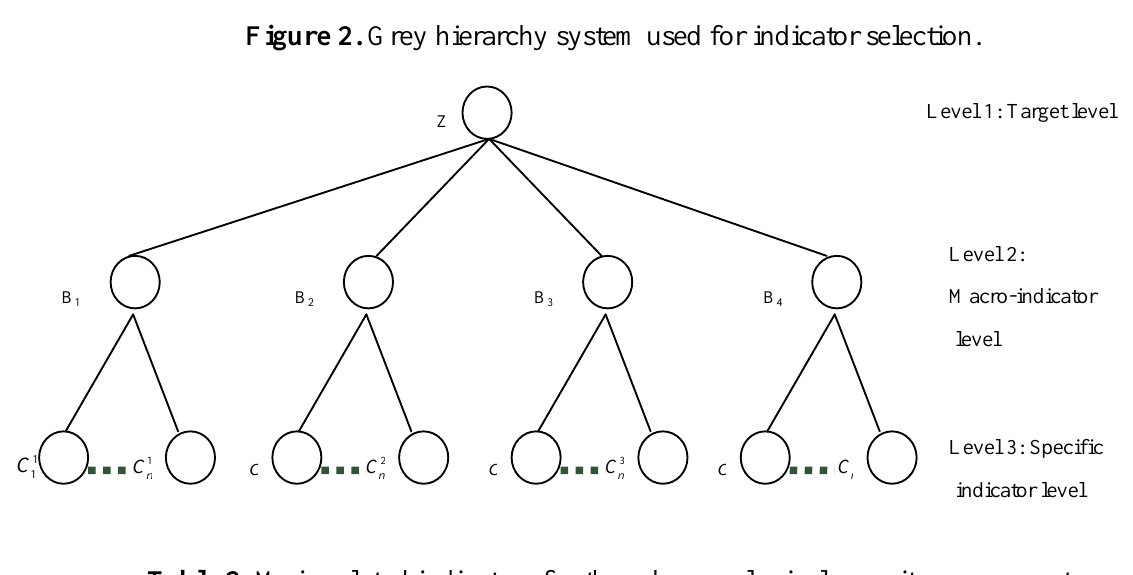
Table 2. Main related indicators for the urban ecological security